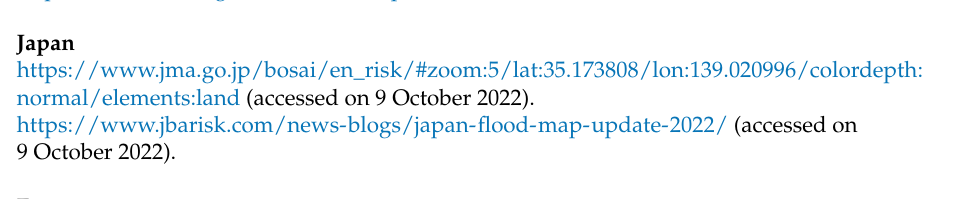
Table 7. Links of the different web viewers on an international